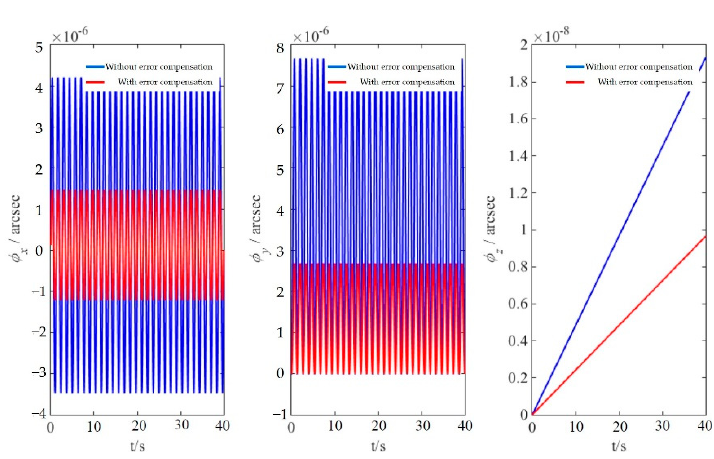
Figure 16. Contrast with or without coning error compensation.